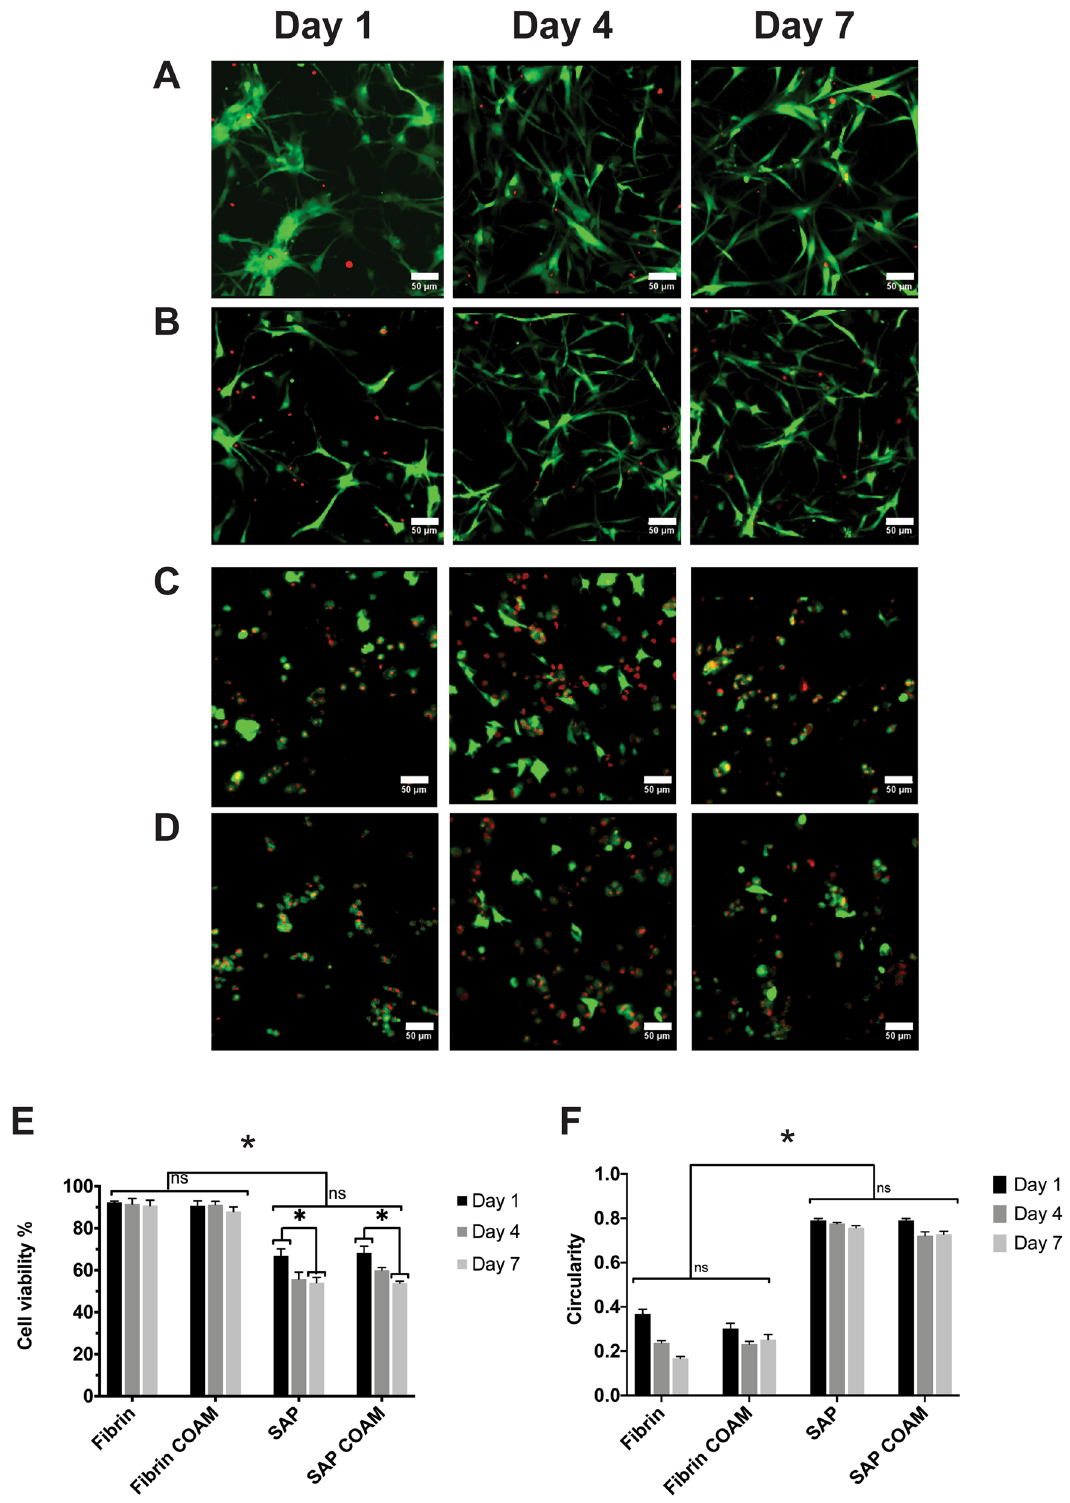
Figure 4. Cell viability (hDPSCs) in cell-laden hydrogels: representative Live/Dead images of hDPSCs encapsulated up to 7 days in ( A ) fibrin hydrogels without COAM, ( B ) fibrin hydrogels with COAM, ( C ) SAP hydrogels without COAM, and ( D ) SAP hydrogels with COAM. ( E ) Quantification of cell viability from Live/ Dead images. ( F ) Cell shape (circularity) analysis from Live/Dead images using ImageJ. Green shows live cells, and red shows dead cells. Scale bars = 50 µm. Results are presented as mean ± SEM. ns refers to not significant, *significant